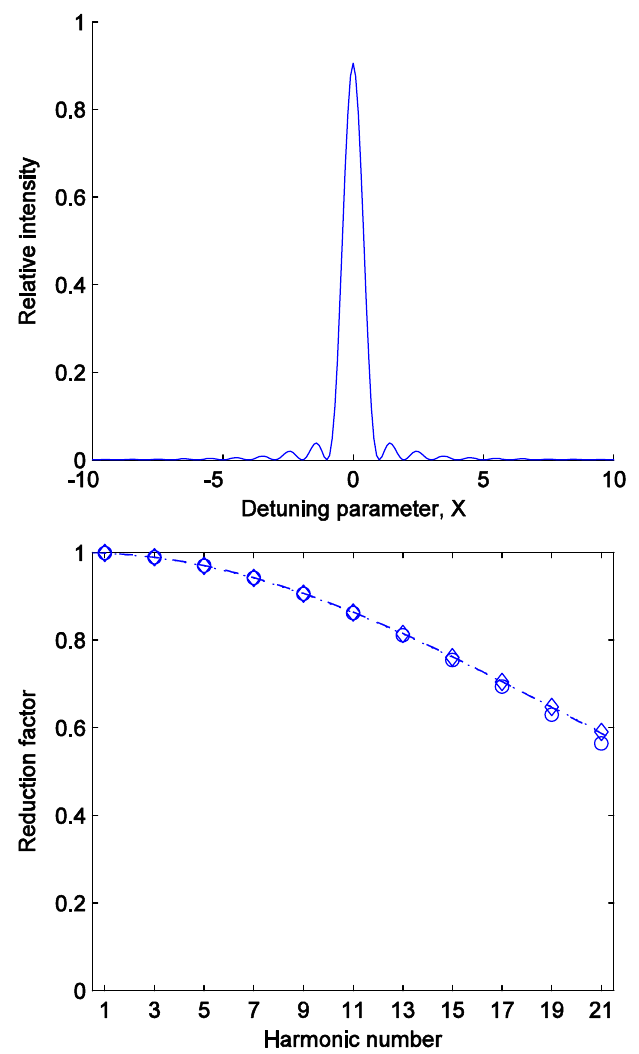
FIG. 14. On-axis single-electron brightness spectrum for the 9th harmonic (upper) and reduction factors (lower) for peak (circles) and integrated (diamonds) brightness as a function of harmonic number (lower) for the phase errors of Fig. 5. The dashed line is Eq. (1) with the relevant phase error (cid:1)